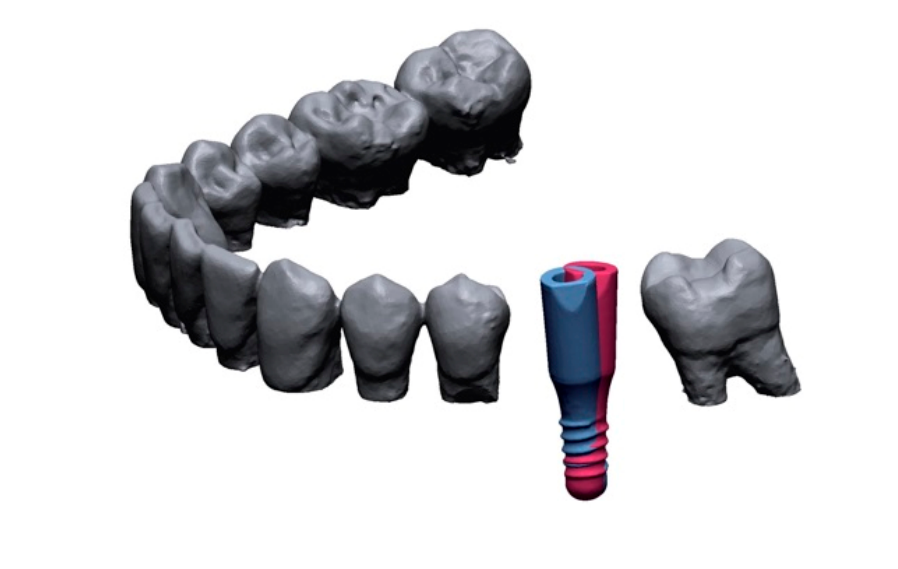
Figure 1. Illustrative slices from MRI ( top ) and CBCT ( middle ) scans. Virtual implant placement was performed twice in each imaging modality with a time lag in between to prevent learning bias. The slices show superimposition of the two plans in area 36 (blue implant: first implant plan, red implant: second implant plan). Deviations can be seen between the two plans regarding implant tip, entry-level, and axis. Pink: nerve canal (CBCT) and alveolar bundle (MRI). Comparison of the two images reveals that image quality is superior in CBCT, due to its higher resolution and lower susceptibility to motion artifacts. ( Bottom ): The virtual plans of both modalities were exported from the 3D planning software and imported into reverse-engineering software. Using this software, geometric deviations were evaluated at the implant tip, entry-level, and axis.